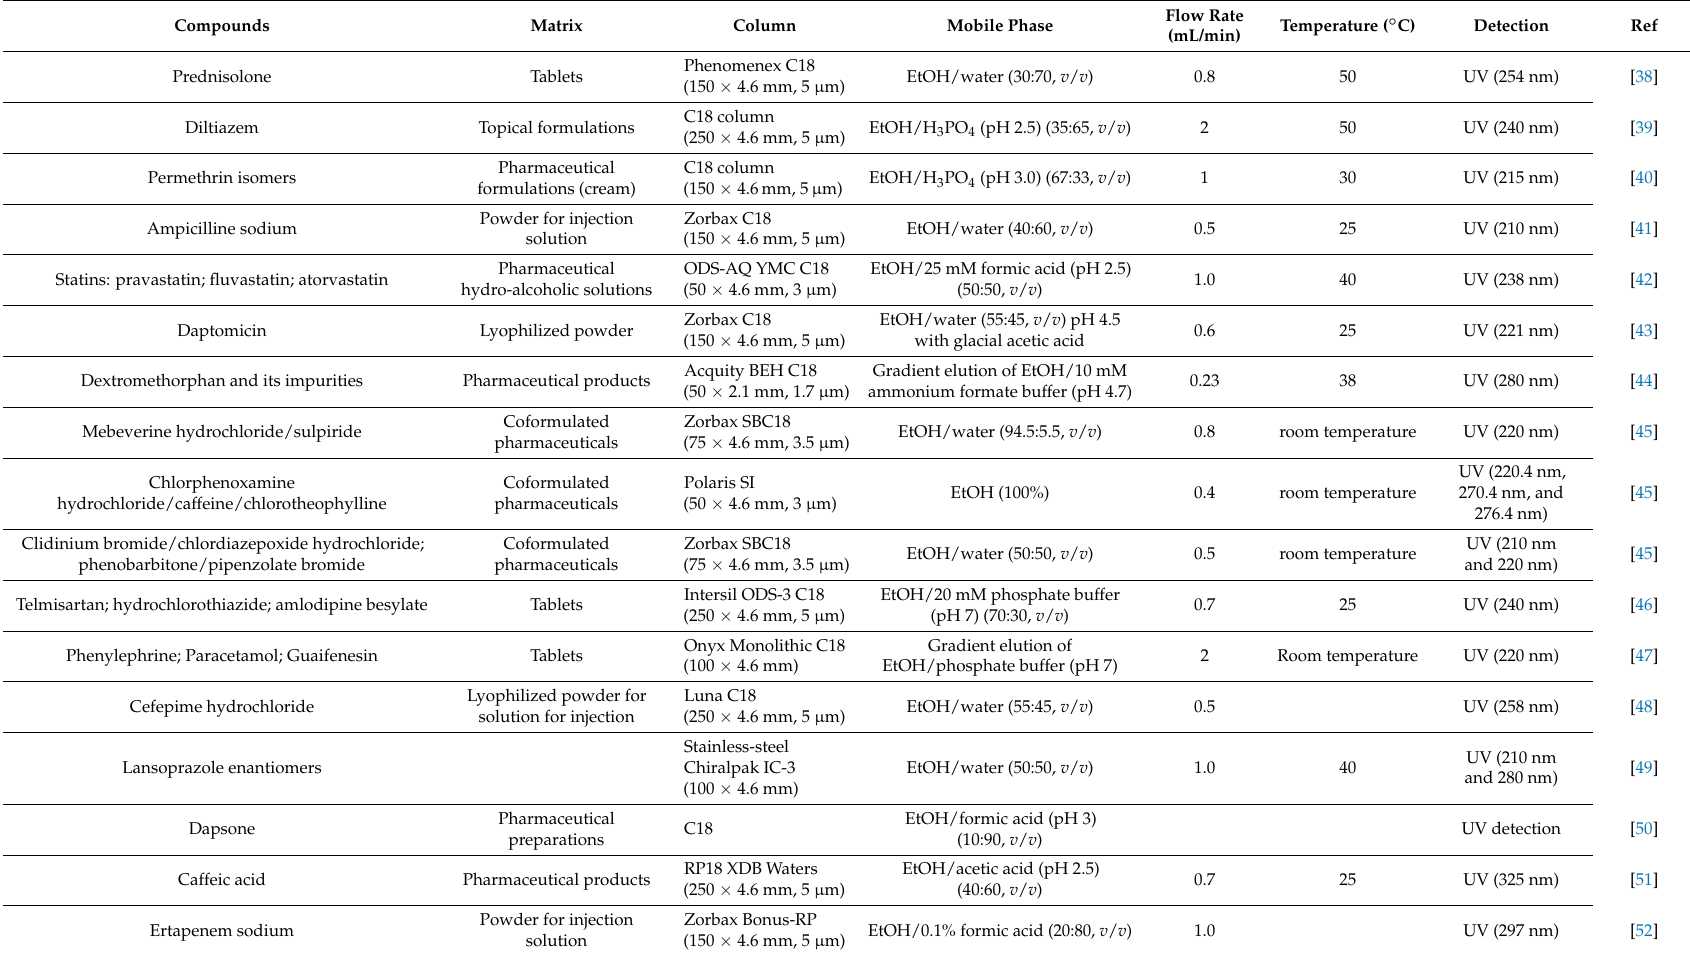
Table 1. Examples of pharmaceutical analysis in RP-HPLC using ethanol-based mobile